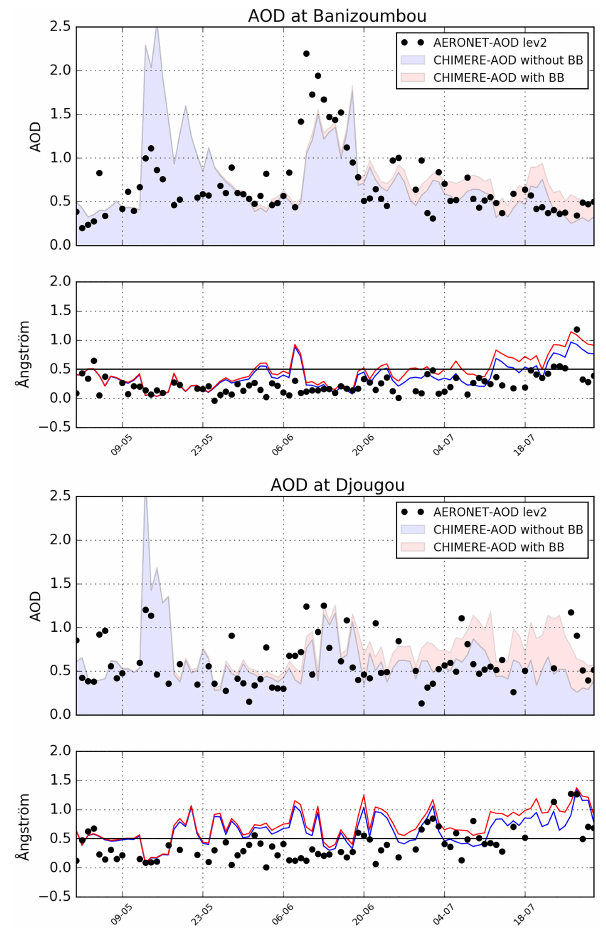
Figure 3. Observed daily averages of AERONET level 2 AOD and Ångström exponent (black dots) at Djougou (Benin) and Banizoum- bou compared to the modeled time series with a splitting to extract the relative contribution between without biomass burning emis- sions (including anthropogenic, biogenic, sea salt and mineral dust; all four in blue) and with biomass burning emissions (in